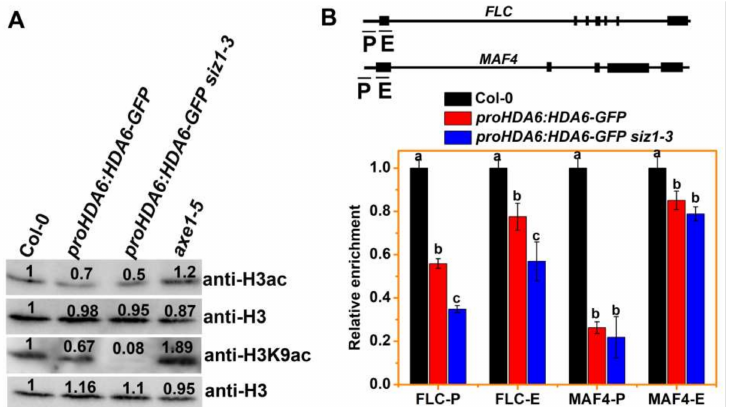
Figure 3. SIZ1 inhibits the activity of HDA6 during flowering. ( A ) Immunoblot analyses of total histone extracted from 15-day-old plants of WT, proHDA6:HDA6-GFP , proHDA6:HDA6-GFP siz1-3 , and axe1-5 with indicated antibodies. Histone H3 antibody is shown as a loading control. The numbers shown on the gels represent the quantitative results (in arbitrary units). ( B ) Overexpression of HDA6 decreased the H3ac level on FLC and MAF4 loci. Upper panel: Schematic diagram of FLC and MAF4 loci. P and E represent the promoter and first exon region, respectively. Lower panel: ChIP analysis of H3ac levels on the FLC and MAF4 loci. Fifteen-day-old plant samples were collected for further analysis. The amounts of DNA after ChIP were quantified by qPCR and normalized to ACTIN2 . Error bars correspond to standard deviations from three biological replicates. Different letters above bars indicate a significant difference between the mutant and WT ( p < 0.05, post hoc